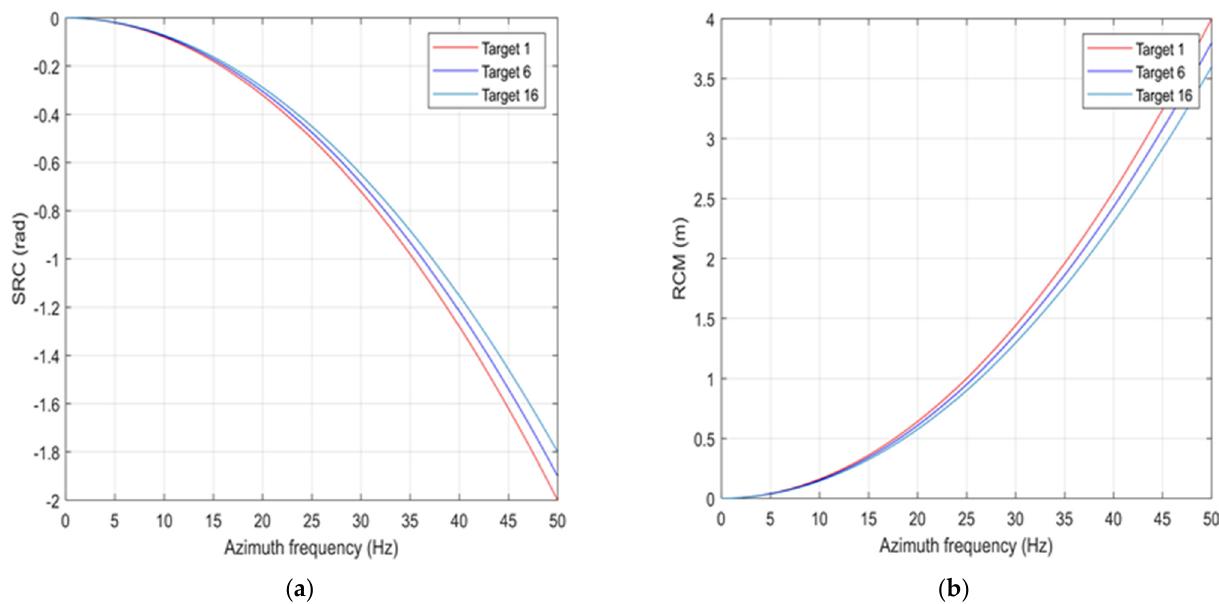
Figure 4. Positions of the 25-point targets in the imaging region.